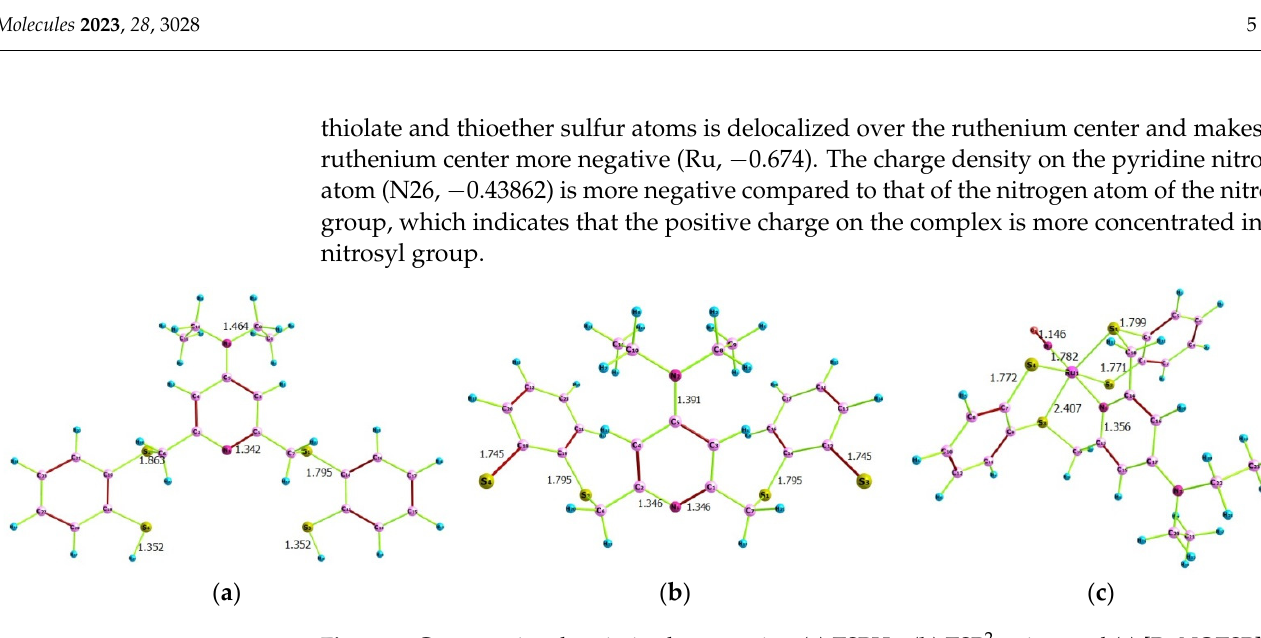
Figure 2. Computational optimized geometries: ( a ) TSPH 2 , ( b ) TSP 2 -anion, and ( c ) [RuNOTSP] + .